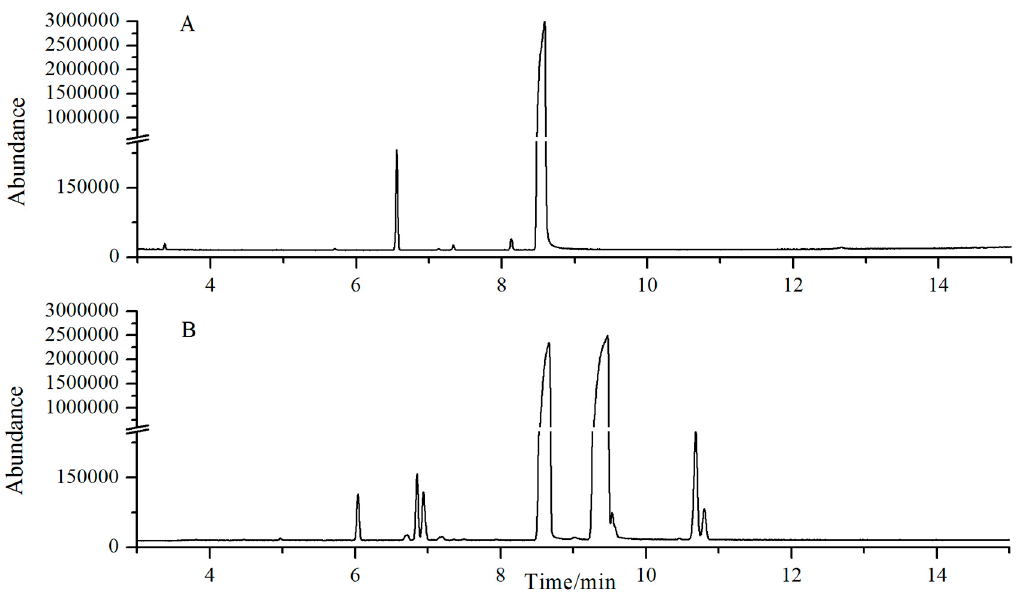
Figure 1. The typical GC-MS analysis chromatogram of NB ( A ) and SB ( B ).